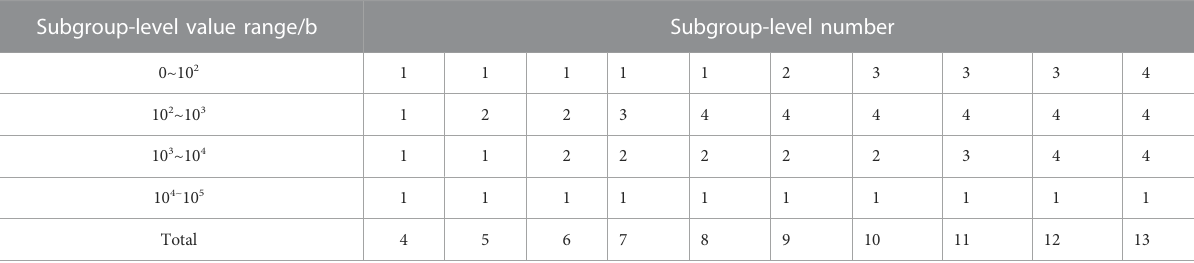
TABLE 5 Subgroup-level values chosen for each interpolating